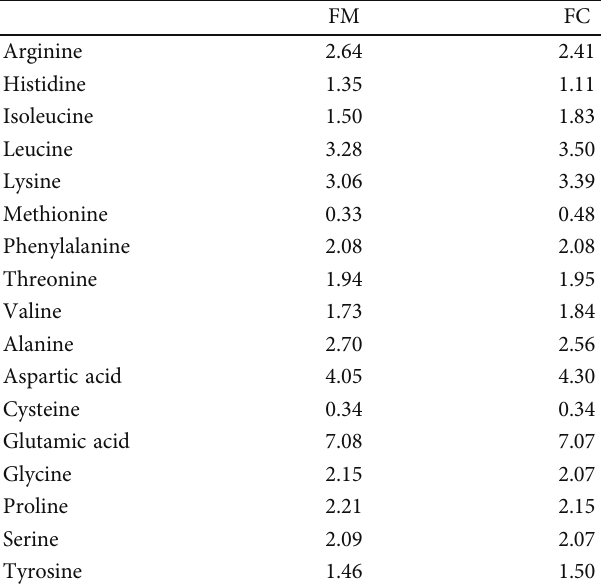
Table 2: Amino acid (AA) compositions of the FM and FC experimental diets (%, dry